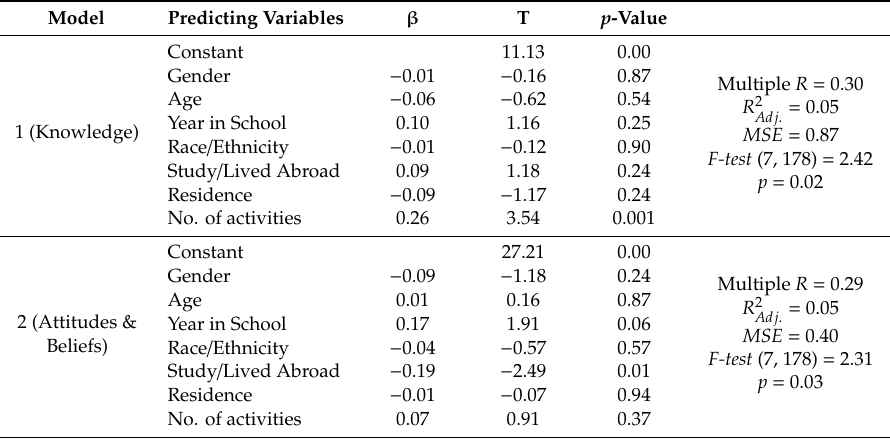
Table 6. Multiple regression analyses of general KAB and predictors ( n =